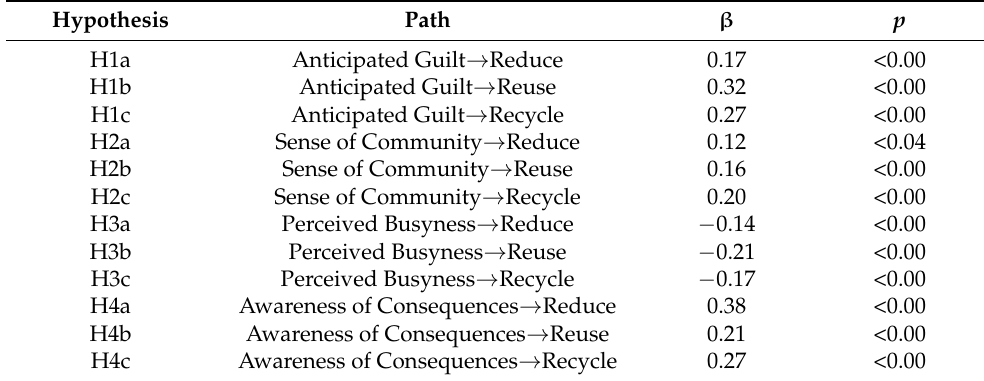
Table 6. Summary of all Hypotheses